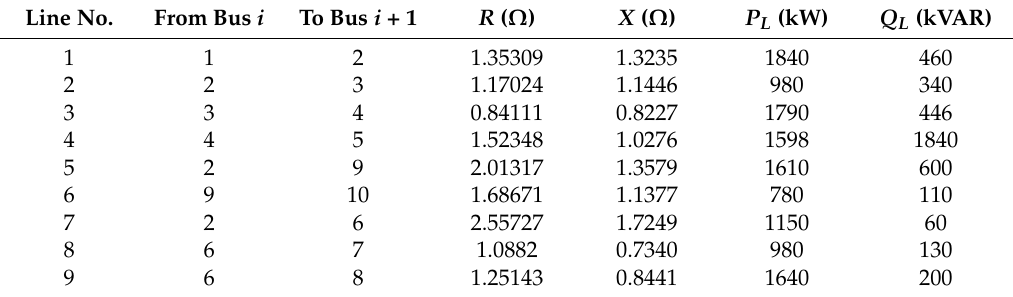
Table A1. 10-bus test system data.